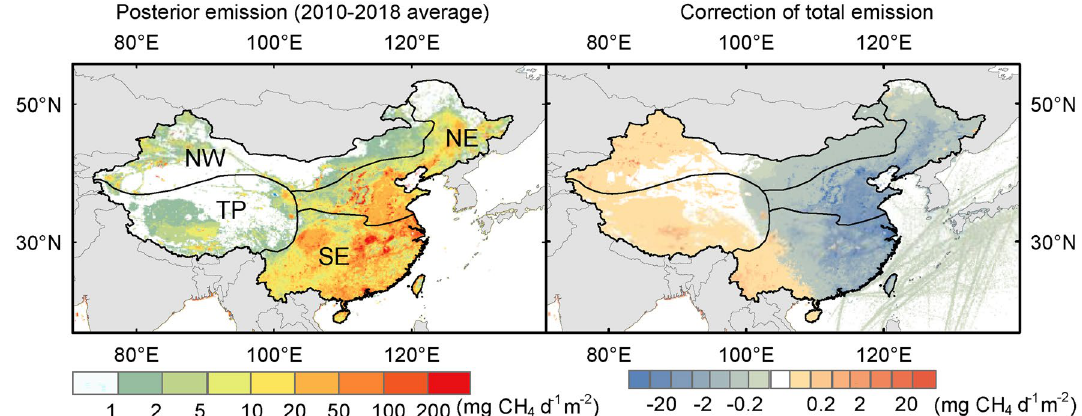
Figure 1. The emission estimates for 2010–2018 and the model corrections to net emissions in China. The four regions are the north-eastern China (NE), the south-eastern China (SE), the north-western China (NW), and the Qinghai-Tibetan Plateau (TP) areas. (Figures generated by ArcGIS Desktop 10.5.1, https:// deskt op. arcgis. com/ en/ arcmap/